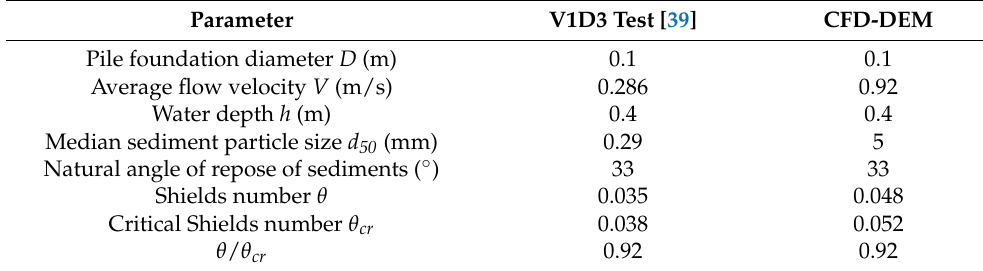
Table 1. Comparison of scour conditions.